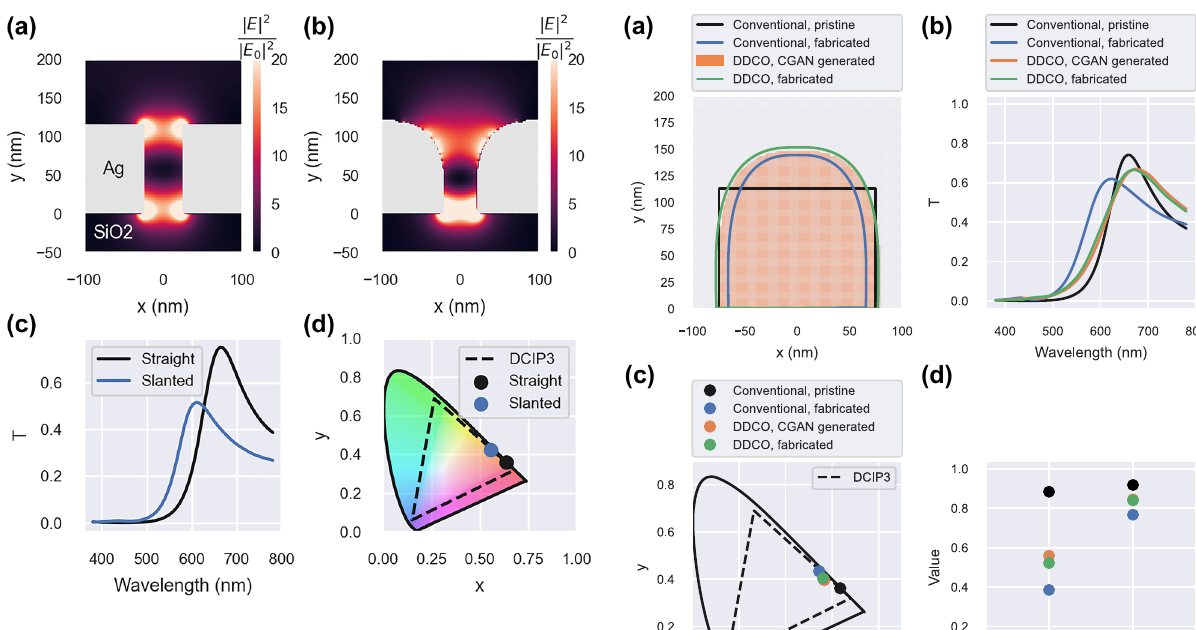
Figure 4: Impact of wall quality. (a)Magnitudeoftheelectricfieldattheresonancewavelength(664nm) in a grating structure with straight walls. (b) Magnitude of the electric fi eldatthe resonancewavelength(605nm) ina gratingstructurewith slanted walls. (c) Transmission spectra of straight and slanted walls simulations. (d) Perceived colors assuming a D65 illuminant and projected in the CIE 1931 color space chromaticity diagram. gratingstructuresbasedonthefabricationconditions.During